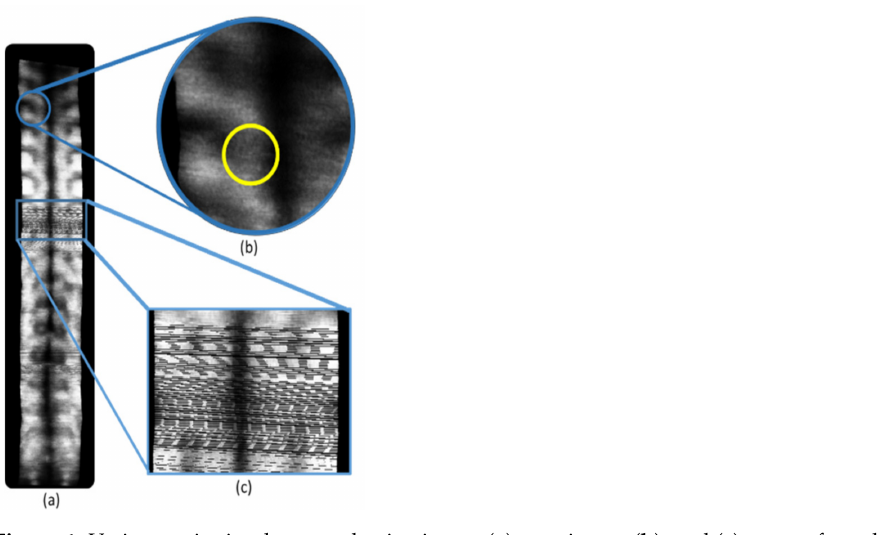
Figure 1. Various noise in ultrasound spine image ( a ), raw image ( b ), and ( c ) types of speckle